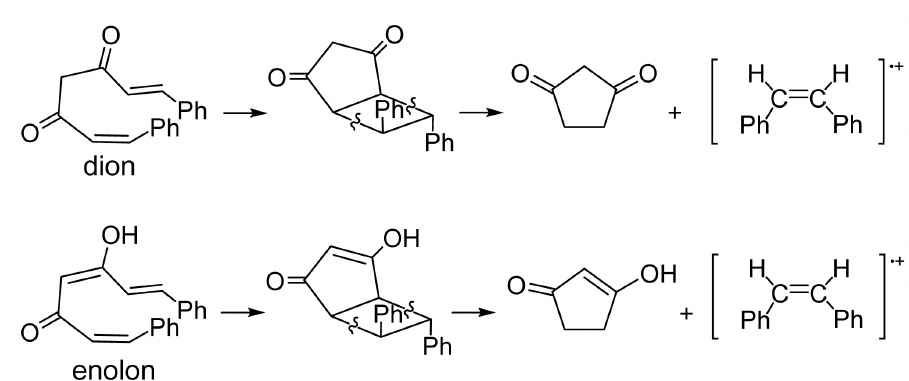
Scheme 4. Fragmentations of 1,7-diphenylhepta-1,6-diene-3,5-dione in the EI mass